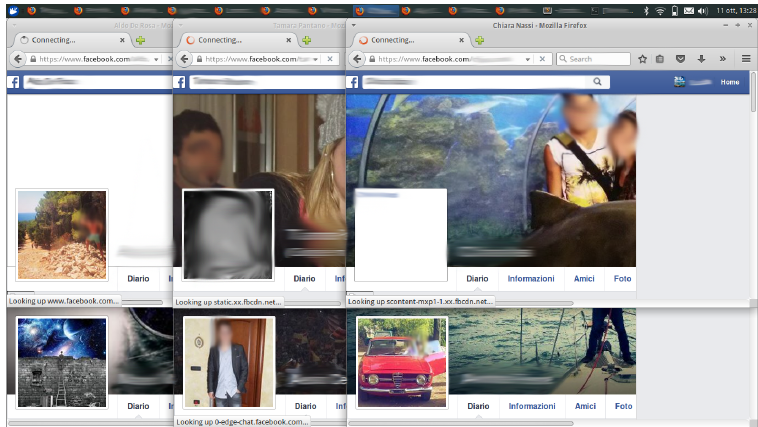
Figure 5. Pool of bots triggering push notifications to a set of